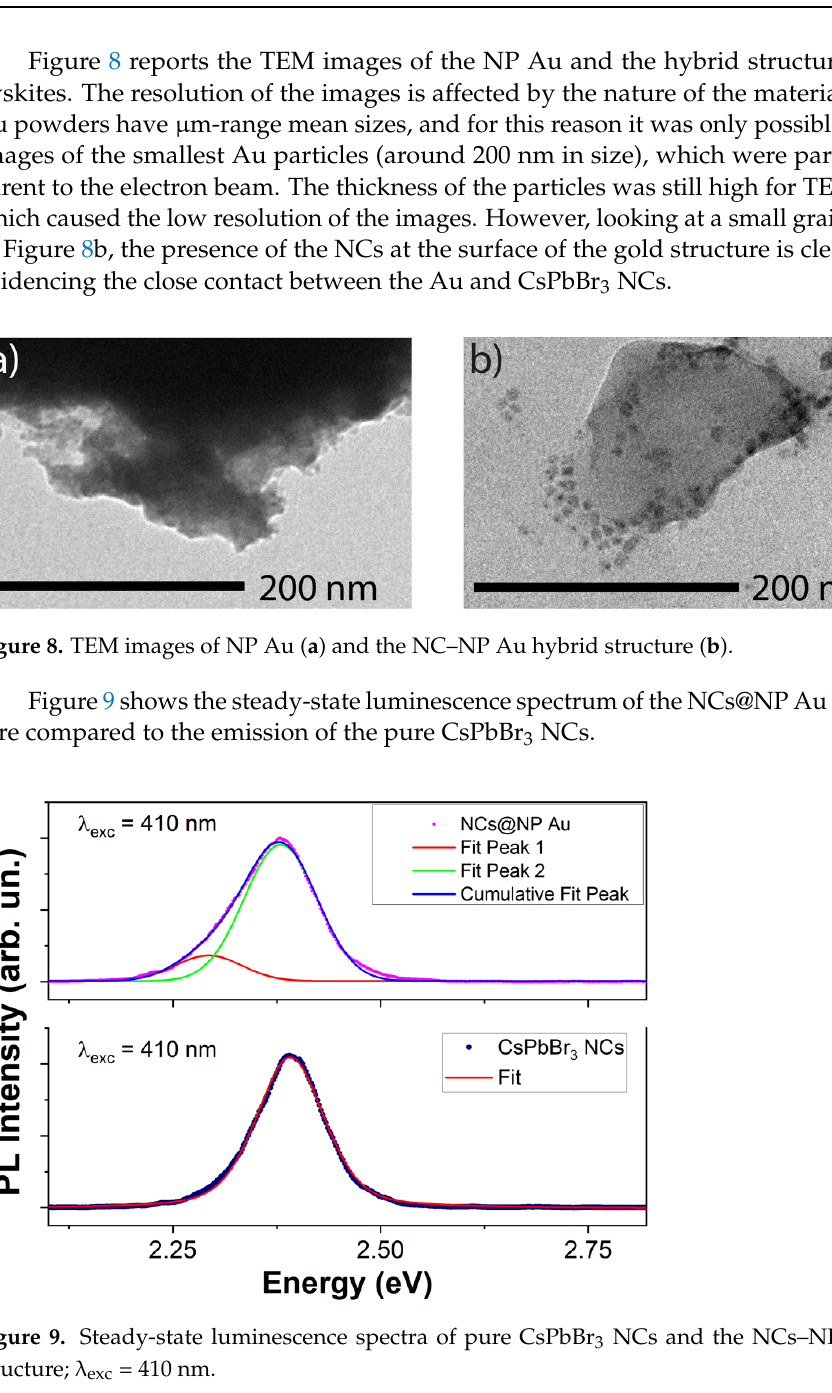
Figure 9. Steady-state luminescence spectra of pure CsPbBr 3 NCs and the NCs–NP Au hybrid structure; λ exc = 410 nm.